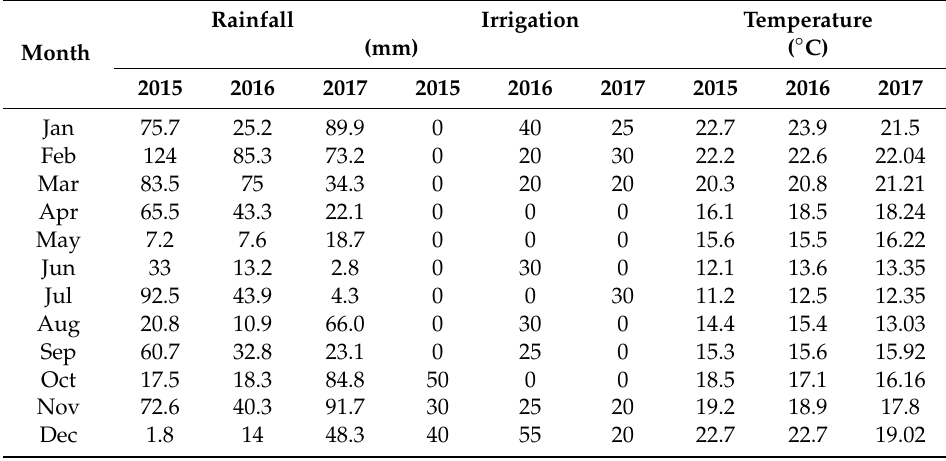
Table 3. Rainfall and irrigation water received during periods of summer maize and cover crops growth (2015–2017). Rainfall Month